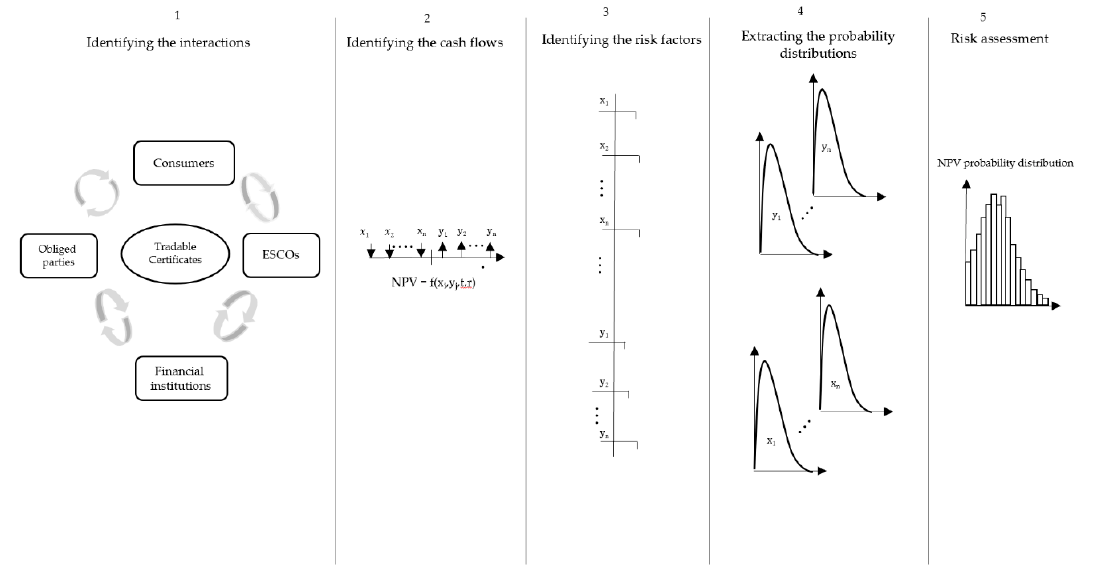
Figure 3. The steps for risk assessment of ESCO in this study (source: categorized by authors).